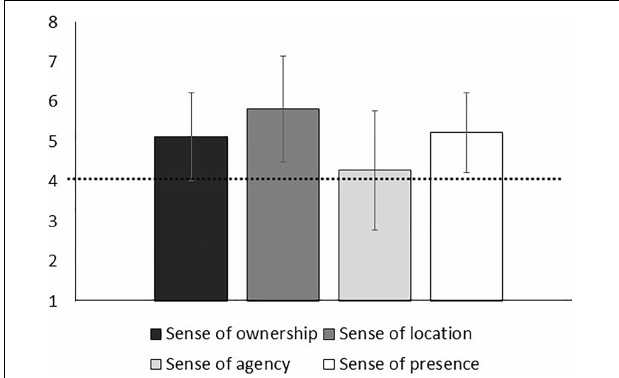
FIGURE 2 | Graphical representation of the sense of embodiment and sense of presence scales ( N = 44). Error bars represent 1 standard deviation from the mean, and the dashed line represents the mean value of the scale (ranging from 1 to